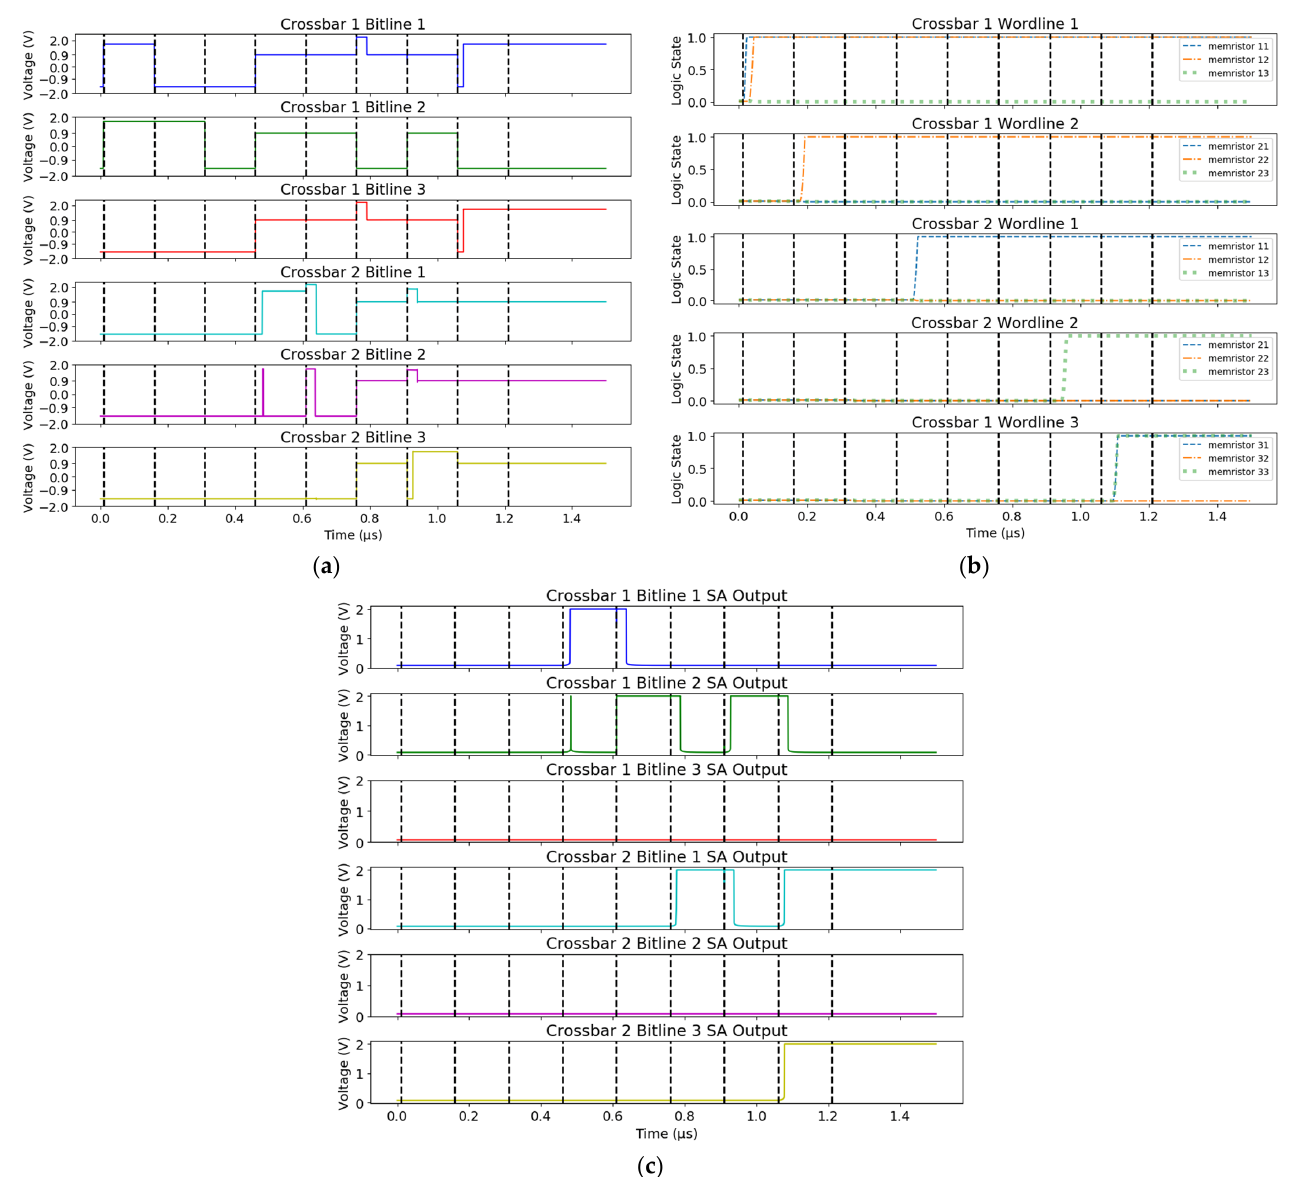
Figure 12. Circuit simulation results for a binary addition performed inside the computational ReRAM. ( a ) Shows the voltages applied to three bitlines of interest in both sub-arrays. ( b ) Shows the evolution of the logic state of the memristors in all the words involved in the computation. Notation “memristor XY” in the legend means the device in wordline X and bitline Y. ( c ) Shows the output voltage of the SA Array modules of the two sub-arrays. Logic “1” corresponds to 2 V in the SA output voltage. Vertical dashed lines designate different 150 ns–wide cycles of operation.